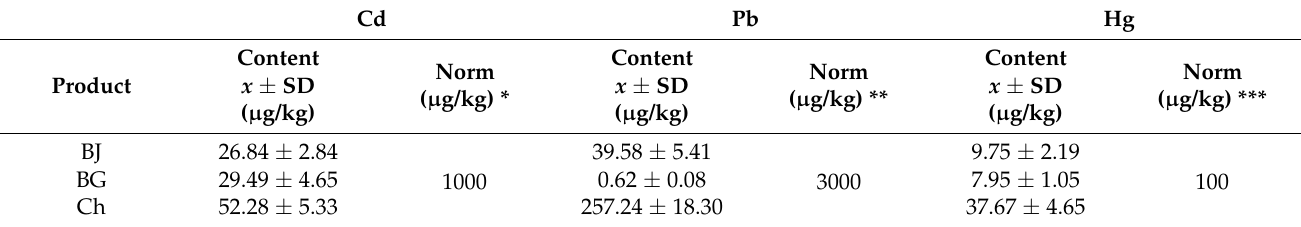
Table 4. Content of toxic elements (Cd, Pb and Hg) in the tested juice of young barley (BJ), barley grass (BG) and chlorophyll (Ch) compared to the maximum